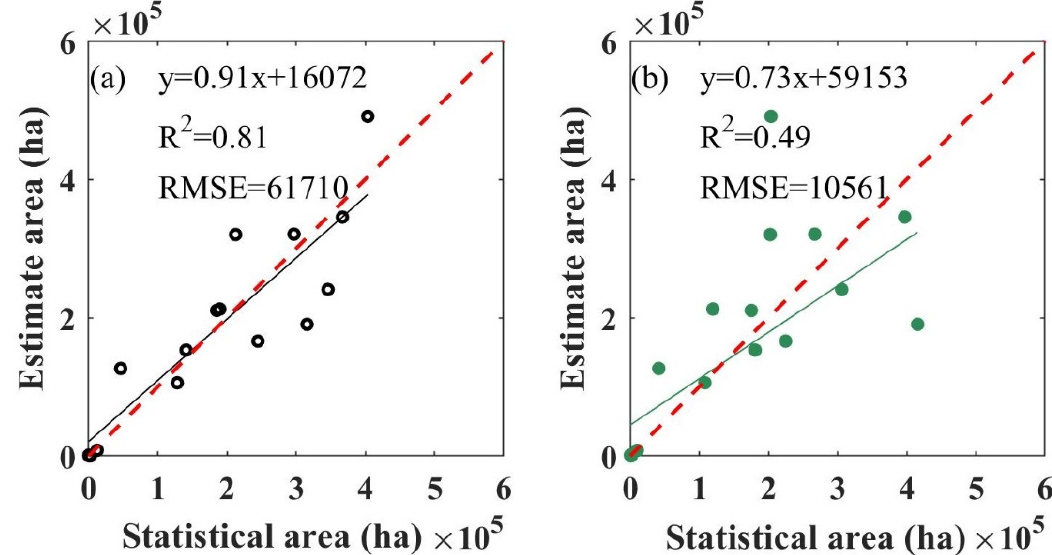
Figure 8. Correlations between the estimated and statistical areas of winter cereals with SAR data ( a ) and without SAR data ( b ) at the municipal level in Germany in 2018.